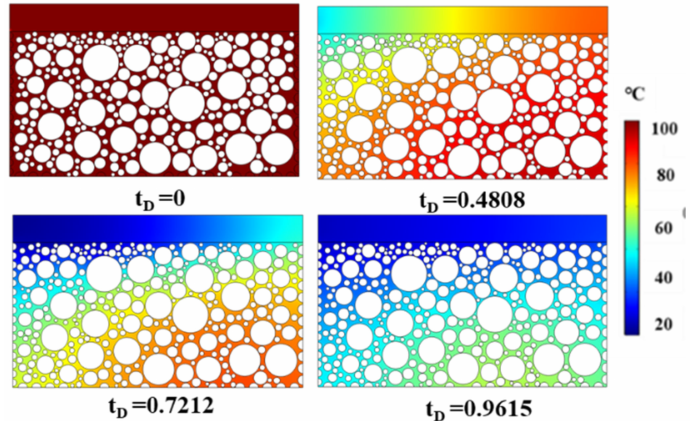
Figure 13. Temperature distribution at different times.